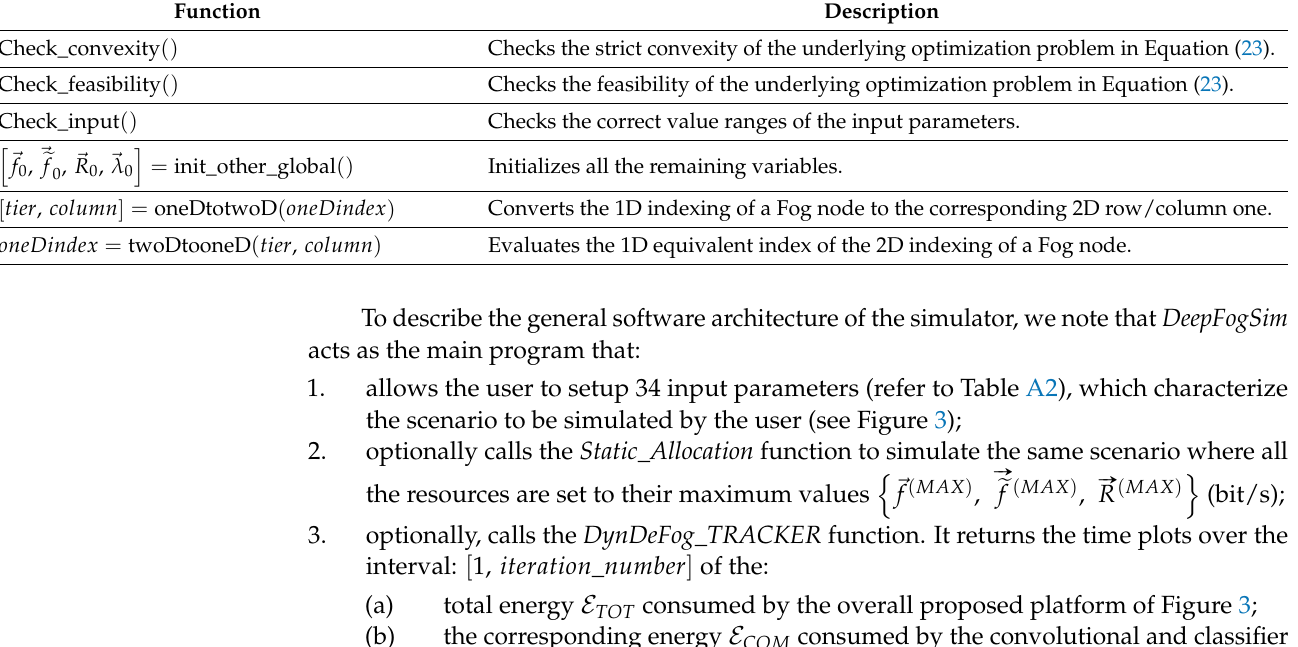
Table 3. Auxiliary functions implemented by DeepFogSim . Function